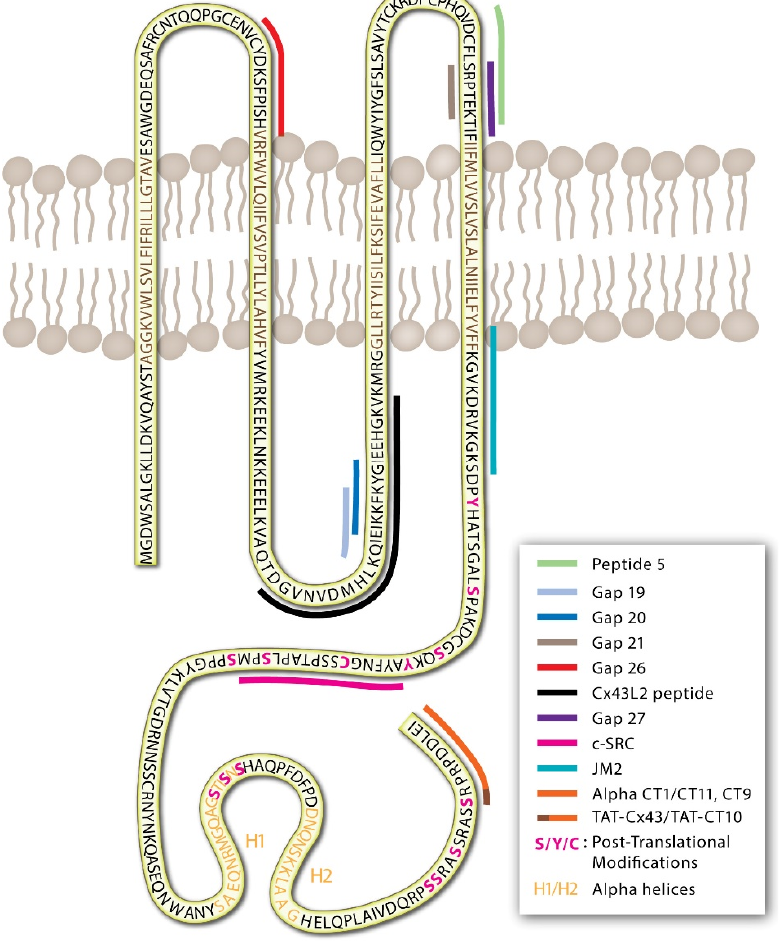
Figure 1. Schematic of the Cx43 protein in the plasma membrane with colored lines indicating the positions of described peptides targeting EL, IL, and CT regions.